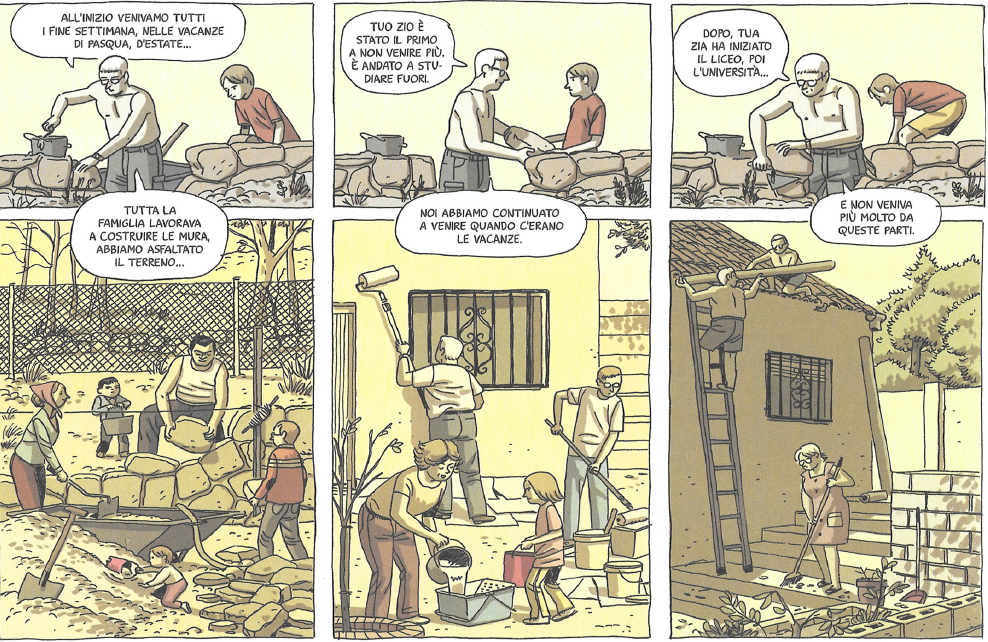
involved in the construction of the house (Roca, 2016, p.